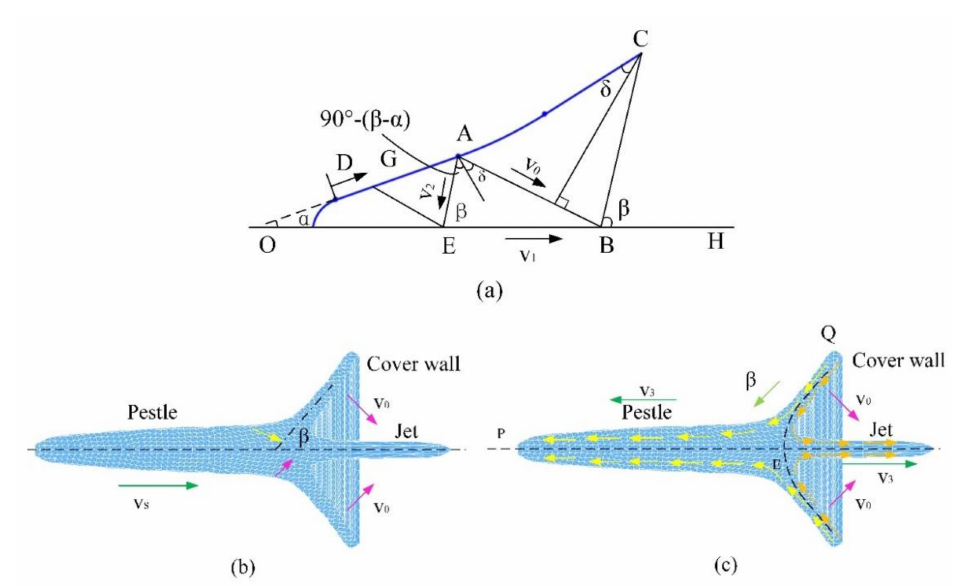
Figure 13. Schematic diagram of the jet formation. ( a ) Calculation graphics; ( b ) Static coordinate system; and ( c ) Moving coordinate